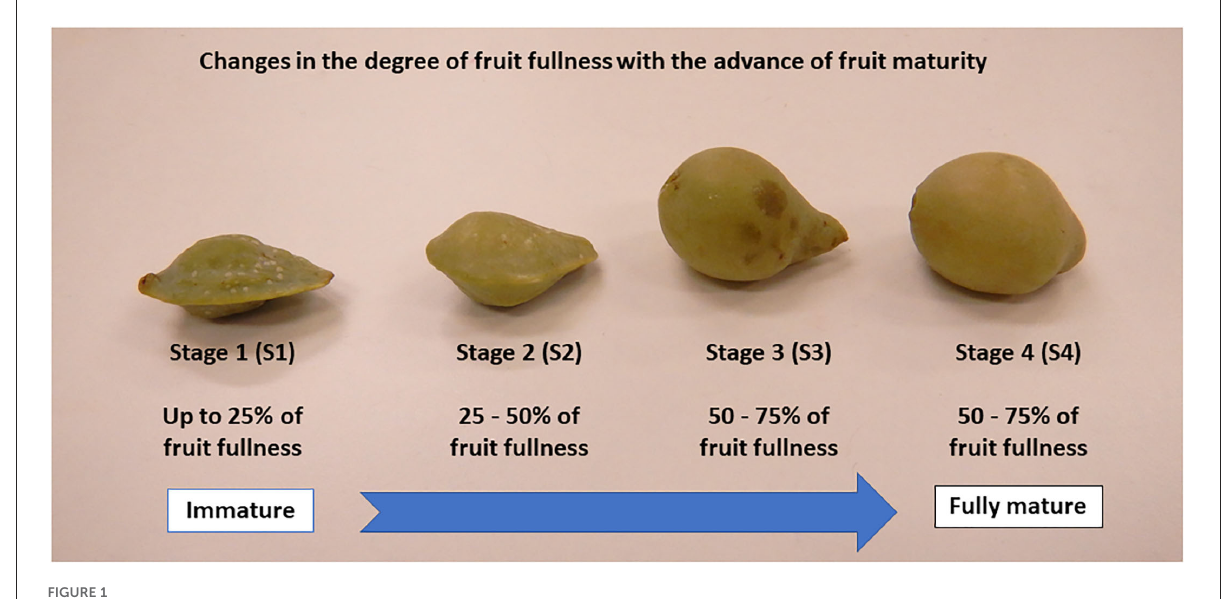
FIGURE1 Changes in the degree of fruit fullness with an increase in fruit